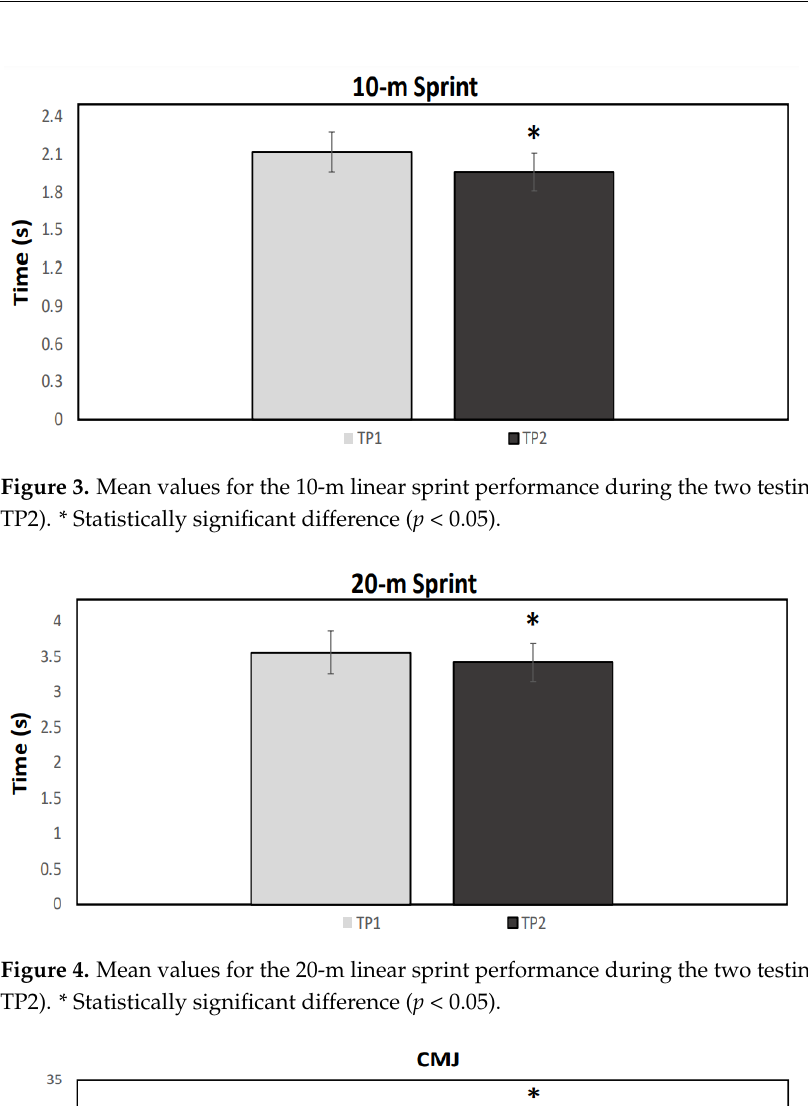
Figure 2. Mean values for the 505 COD test performance for the left leg during the two testing points (TP1 and TP2). * Statistically significant difference ( p < 0.05).